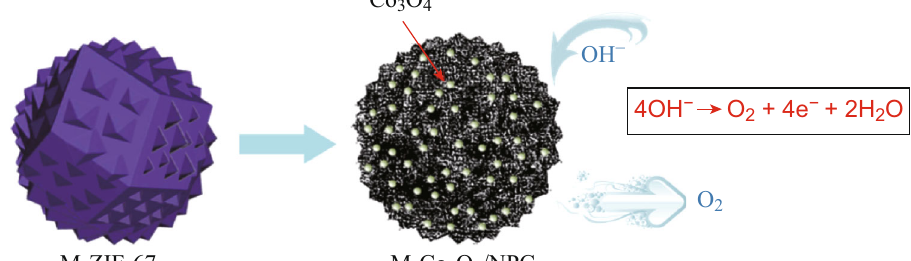
Fig. 11 Schematic diagram of the M-Co 3 O 4 /NPC